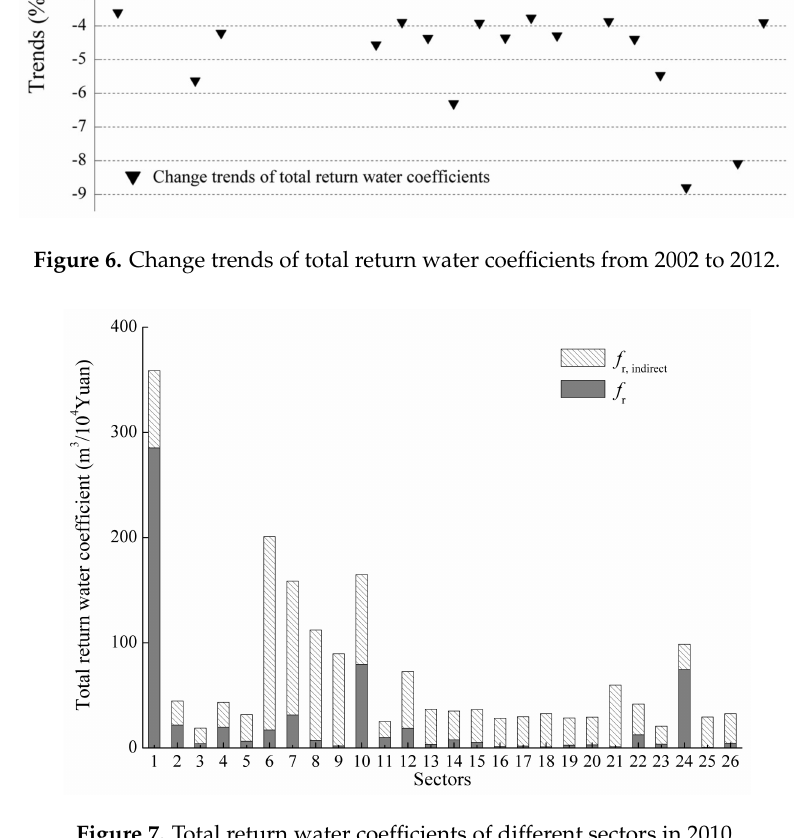
Figure 7. Total return water coefficients of different sectors in